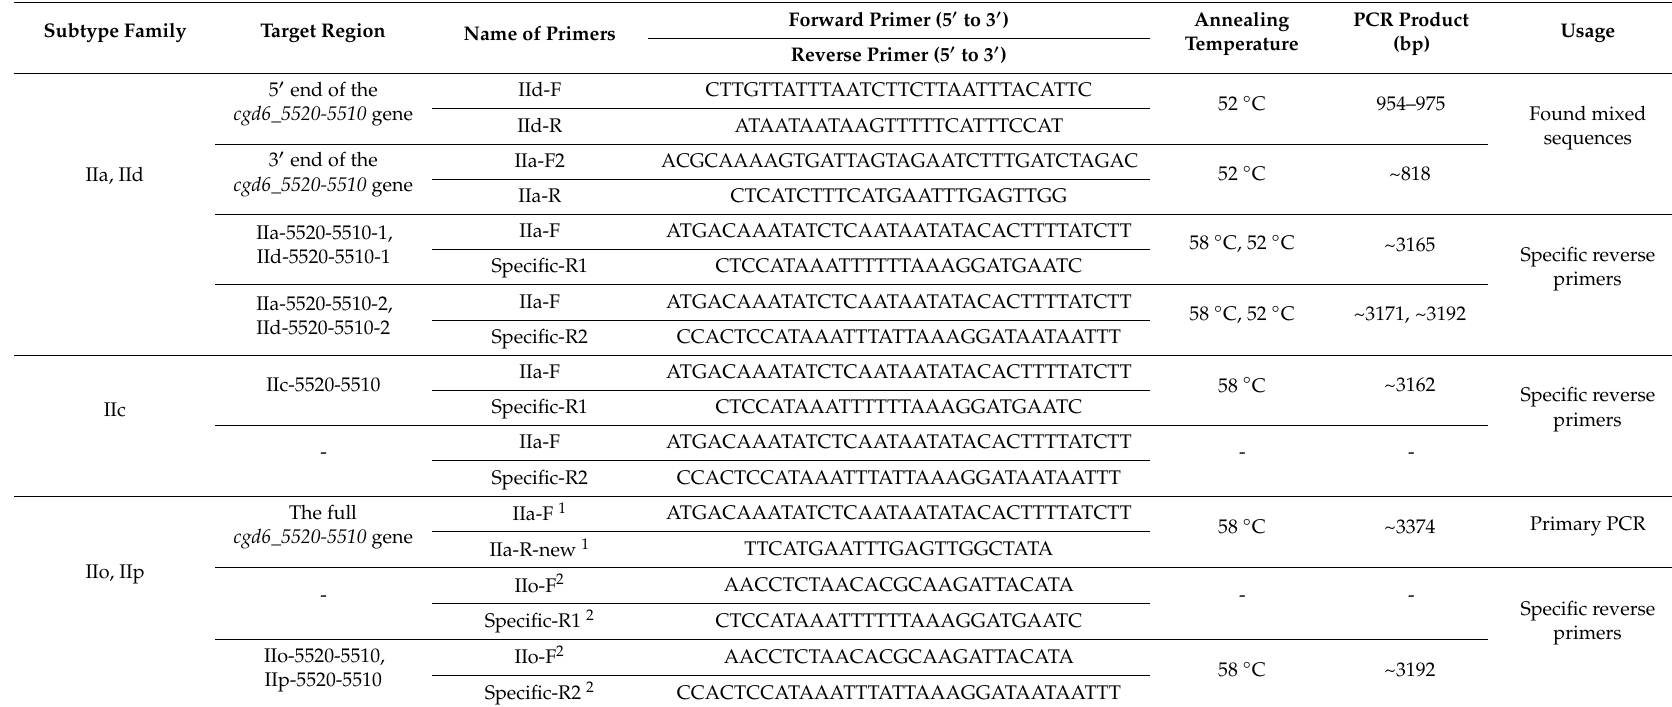
Table 1. Primers designed to amplify the two copies of the cgd6_5520-5510 gene in Cryptosporidium parvum IIa and IId